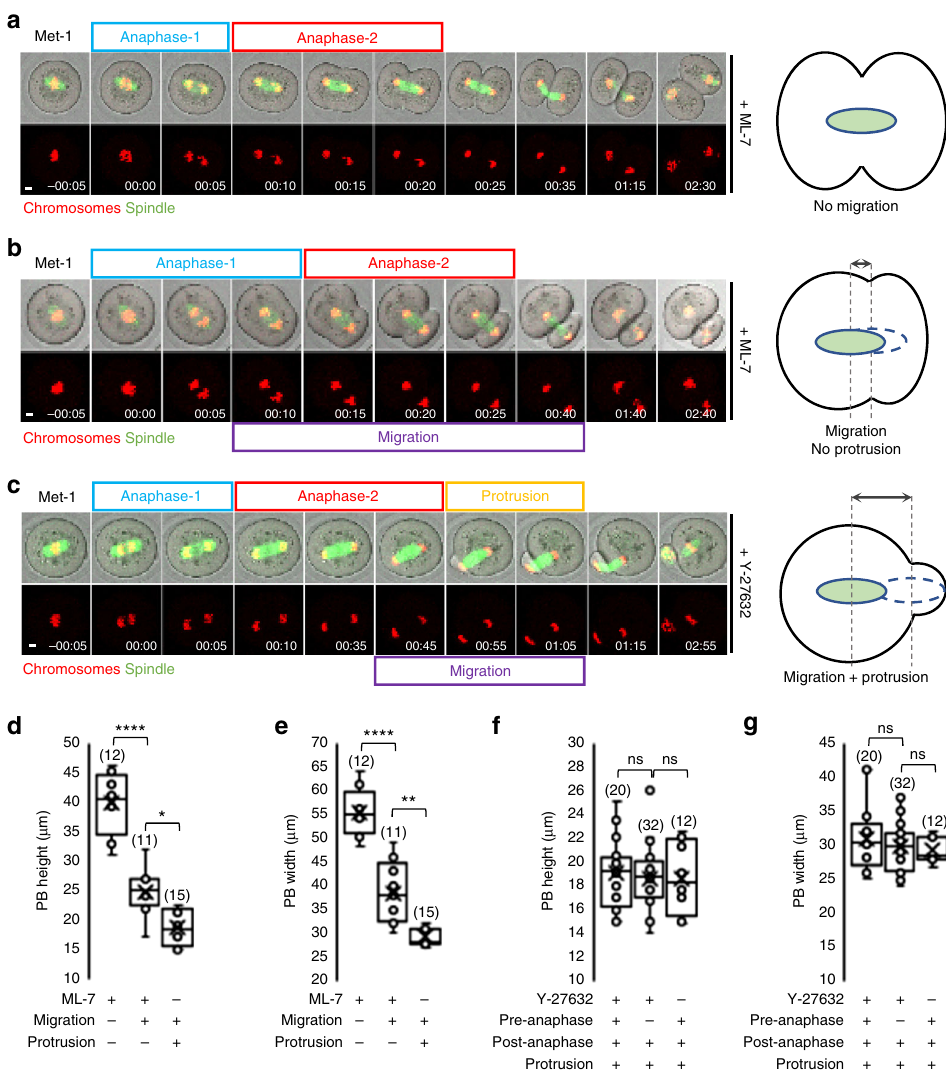
Fig. 6 Extreme asymmetry requires anaphase-spindle migration and protrusion. a – c Live oocytes treated with either ML-7 ( a , b ; see Supplementary Movie 26 and 27) or Y-27632 ( c ; see Supplementary Movie 28) undergoing anaphase at the oocyte centre followed by either no spindle migration ( a ; see Supplementary Movie 26), migration to the cortex without protrusion ( b ; see Supplementary Movie 27) or migration and protrusion ( c ; see Supplementary Movie 28) as depicted in schematics. d – g Polar body (PB) dimensions in ML-7 ( d , e ) and Y-27632 ( f , g ) treated oocytes. Note that Pre-anaphase and Post- anaphase ( f and g ) refer to pre-anaphase and post-anaphase spindle migration, respectively. Box plots depict median (horizontal line), mean (crosses), 25th and 75th percentiles (boxes) and 5th and 95th percentiles (whiskers). One-way ANOVA used for statistical analysis. P values represented as * P < 0.05, ** P < 0.01, and **** P < 0.0001, ns denoted P > 0.05. Times in panels are hours:minutes relative to anaphase-onset. Scale bars, 10 µ m. Oocyte numbers are shown in parentheses from a minimum of three independent